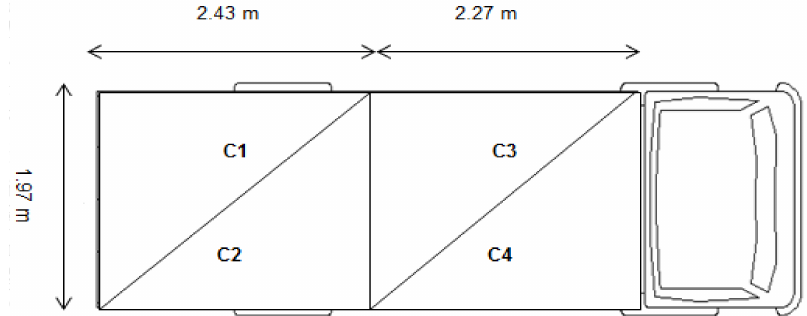
Figure 2. The location of compartments in the truck. ( C1 ) compartment 1; ( C2 ) compartment 2; ( C3 ) compartment 3; ( C4 ) compartment